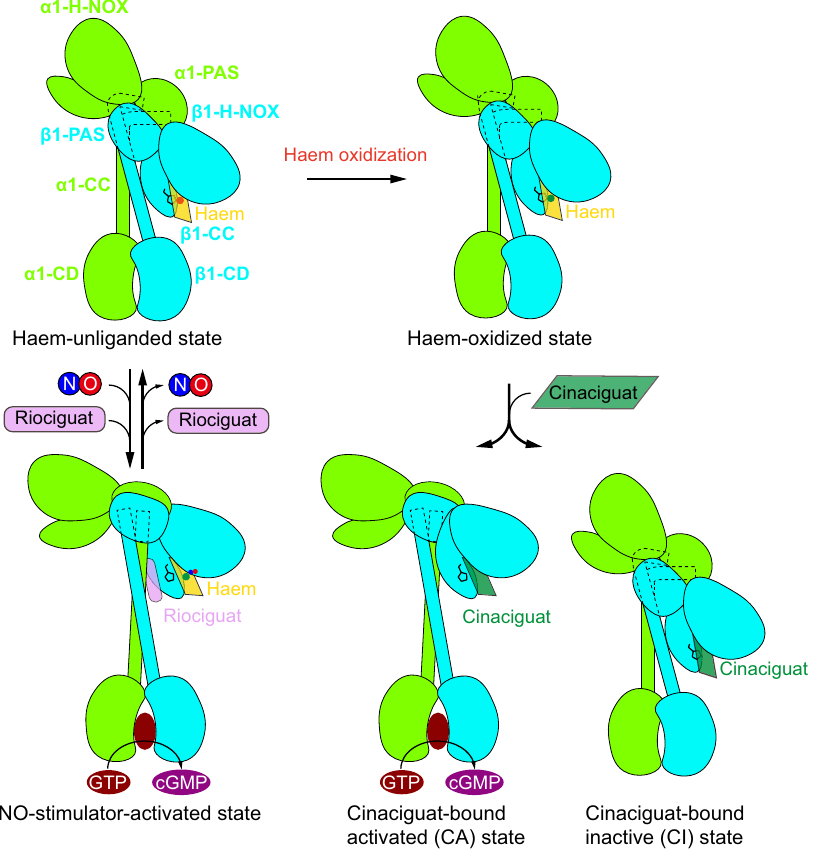
Fig. 5 Activation mechanism of sGC by stimulators and activators. Cartoon models of the sGC structures at different functional states. The colors of each individual subunit are the same as Fig. 1a. In the presence of NO, YC-1 type stimulators bind onto sGC with ferrous haem, between β 1 H-NOX domain and CC domains, to stabilize sGC in the extended active conformation. Cinaciguat bind onto sGC at the haem-oxidized state or haem-free state, inside the β 1 H-NOX domain, and sGC shows both extended active conformation and bent inactive